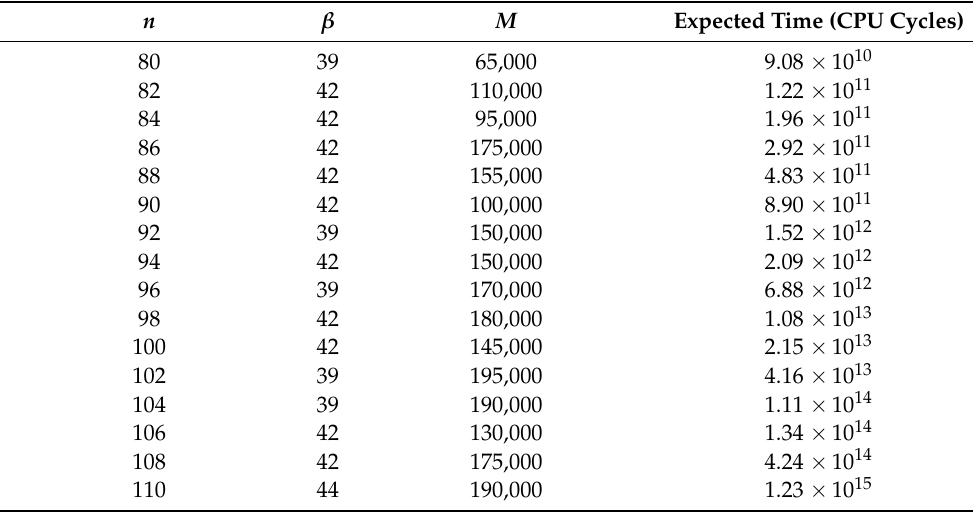
Table 2. Optimal parameters of DP-ENUM for solving SVP challenge. n β